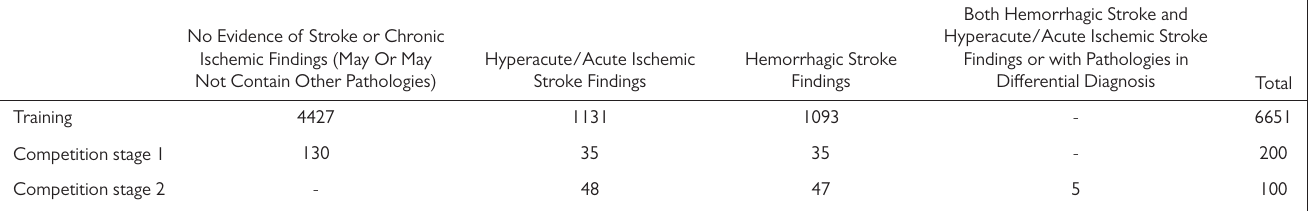
Table 3. The Number of Images in the Training and Competition Data Sets Is Given No Evidence of Stroke or Chronic Ischemic Findings (May Or May Not Contain Other Pathologies)